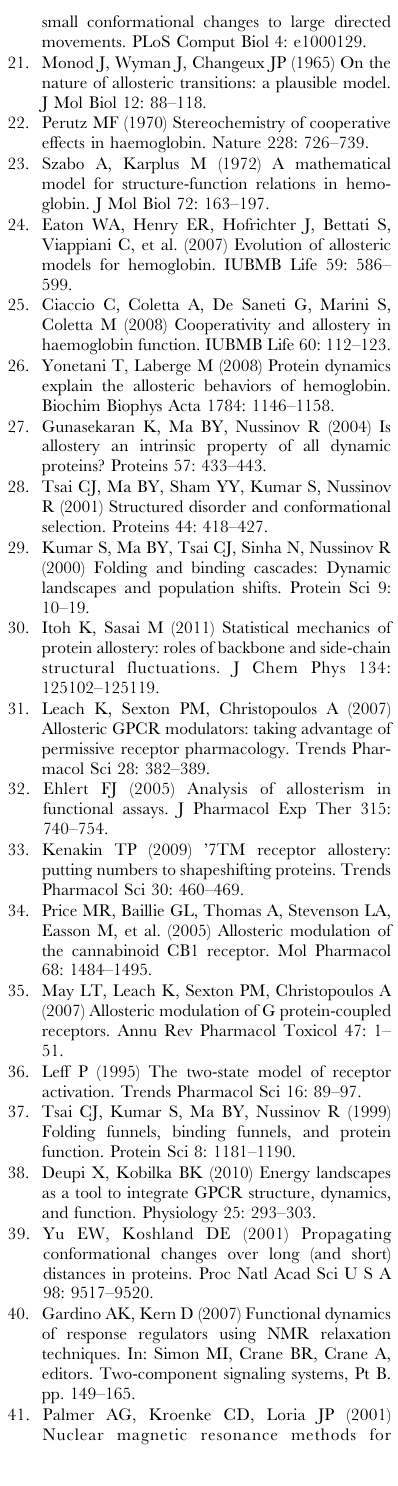
Figure S4 The free energy land- scape of the extended ATSM. The energy landscape drawing is similar to Figure 5A for ATSM with two